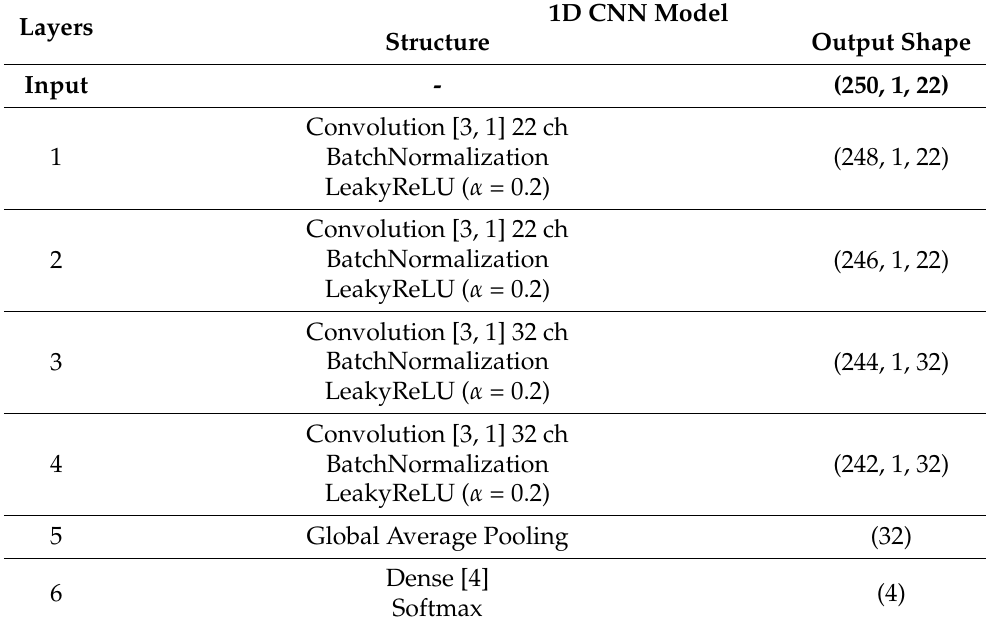
Table 2. The model structure of 1D CNN.